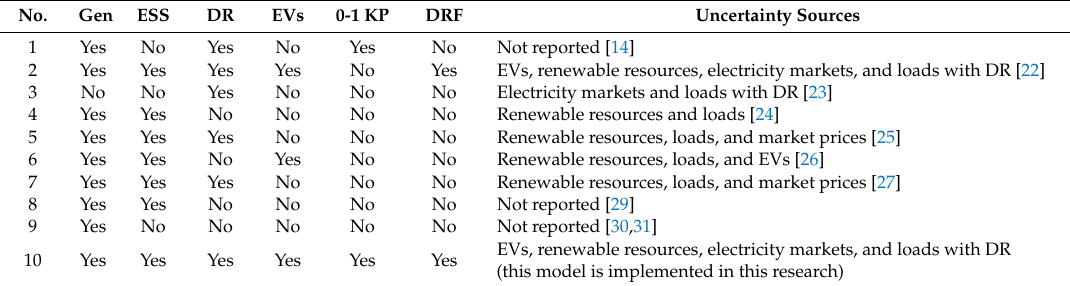
Table 1. Review of microgrids energy resources with 0-1 knapsack problem (KP) and demand response function